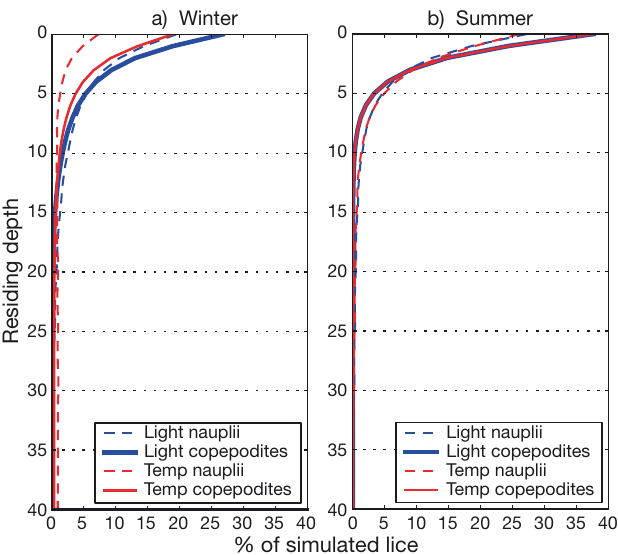
Fig. 10. Emergent vertical distribution of simulated Lepeo - phthei rus salmonis in the Hardangerfjord based on current fields from the model NorKyst800 in (a) winter and (b) sum- mer. The values are integrated over time where the distribu- tions are controlled by migration towards the surface when exposed to light (Light), while avoiding low-salinity water, or by vertical migration to achieve the highest ambient temper- ature (Temp) during the nauplii stages. All copepodites mi - grated towards the surface while avoiding low-salinity water